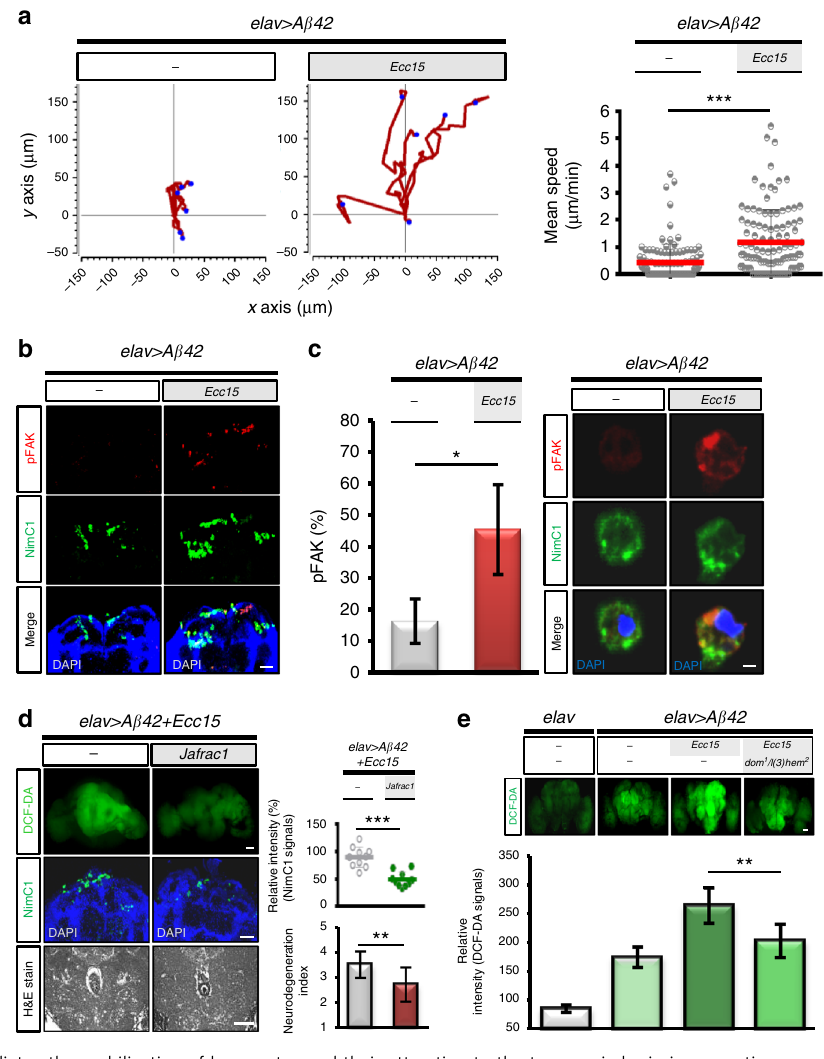
Fig. 4 Gut – brain axis mediates the mobilization of hemocytes and their attraction to the transgenic brain in promoting neurodegeneration. a Time-lapse analysis of plasmatocyte migration after enteric infection. Representative examples of the migration trajectories of plasmatocytes ( n = 6 in each group). b , c Coimmunostaining of phospho-FAK and NimC1 in plasmatocytes recruited transgenic brains b or in circulation c . Phospho-FAK, red ; plasmatocytes, green ( n = 15 in each group). d DCF-DA ( upper panel) and NimC1 ( middle panel) staining and histology ( bottom panel) in the transgenic brains with or without overexpressing Jafrac1. e DCF-DA staining in transgenic brains with or without hemocyte de fi cient background. elav > A β 42 transgenic or control ( elav alone) fl ies with or without Ecc15 intestinal infection were analyzed at 10 dpi. DCF-DA signal, ROS stress; NimC1 signal, plasmatocyte. Brain histology, n = 10 each group. Quantitative data are presented as the mean ± SD of three independent experiments. * P < 0.05, ** P < 0.01, *** P < 0.001; NS, not signi fi cant, H&E, haematoxylin and eosin. Scale bars, 50 μ m b , d and e ; 5 μ m